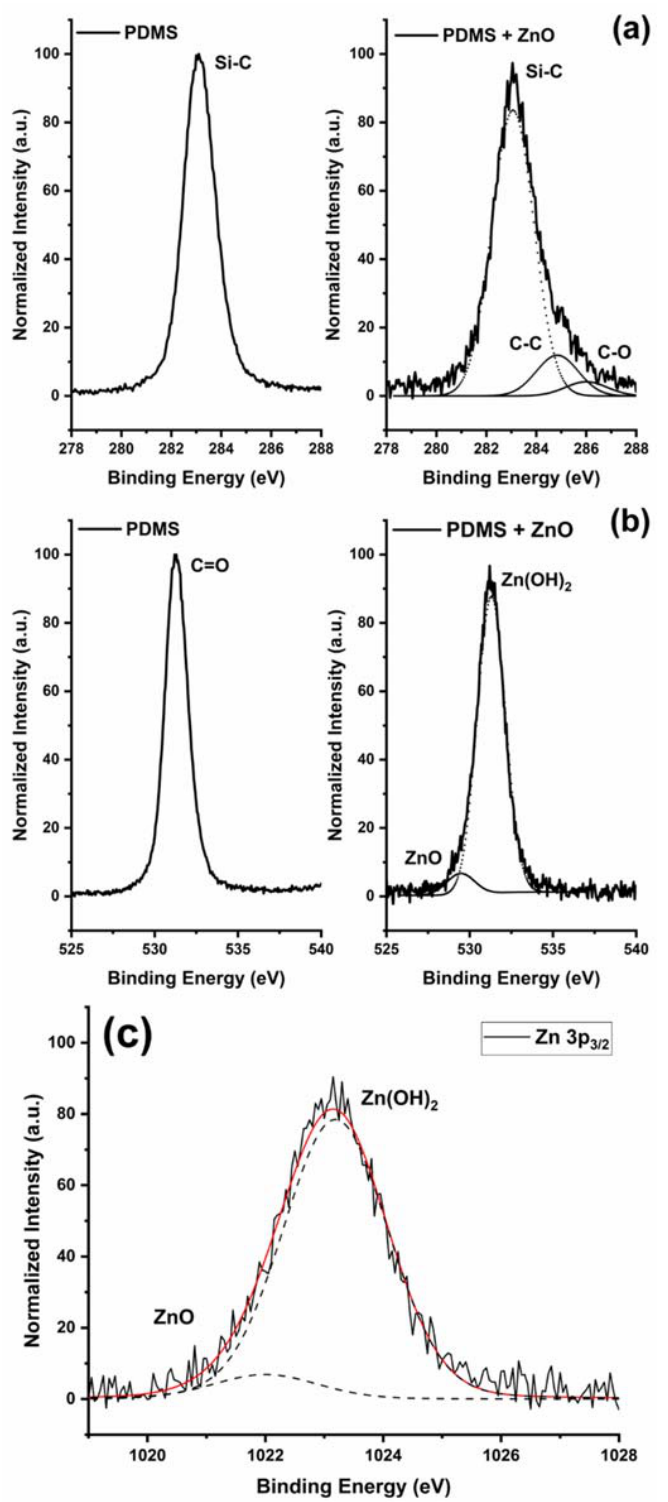
Figure 7. PDMS reference (dotted lines) and PDMS-ZnO treated slub (solid lines) spectral comparison of C1s ( a ), O1s ( b ), and Zn2p3/2 ( c ), X-ray photoelectron peaks.